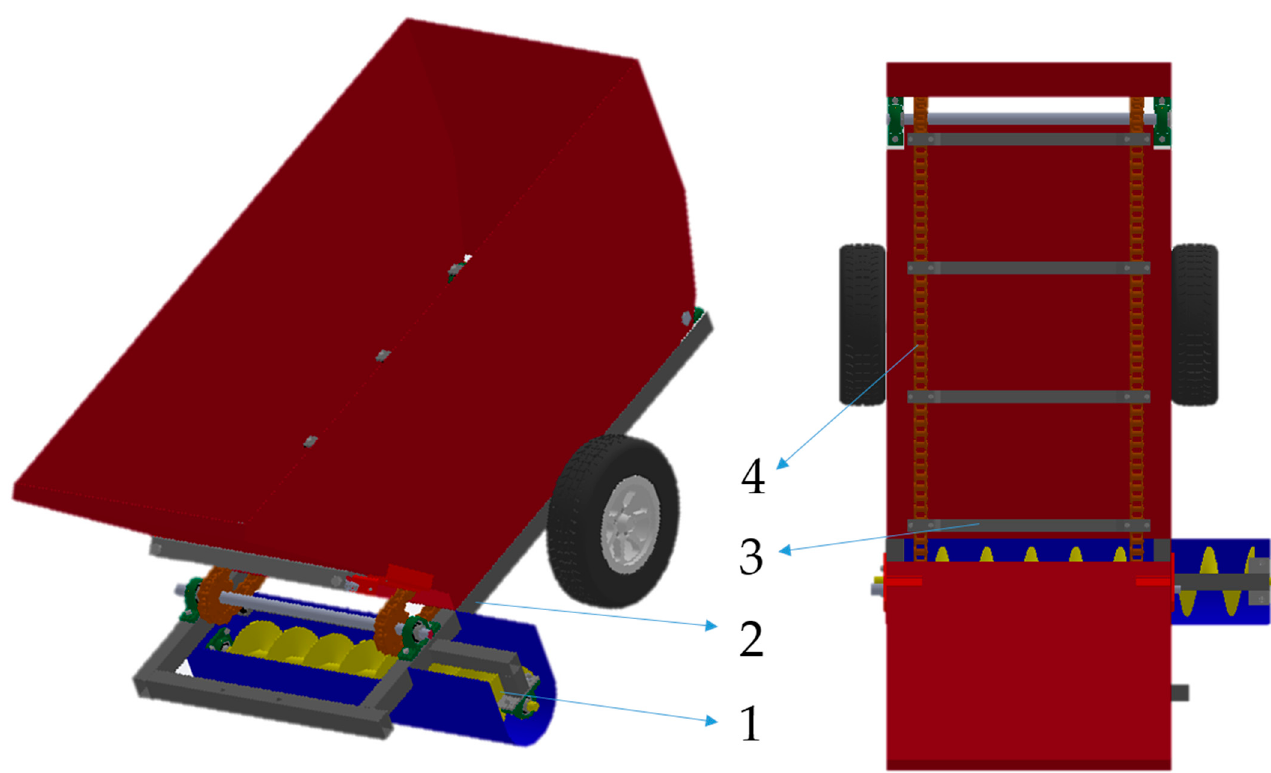
Figure 2. Schematic diagram of the combined fertilization device structure. 1—Spiral conveyor, 2—frame, 3—scraper chain, 4—scraper.